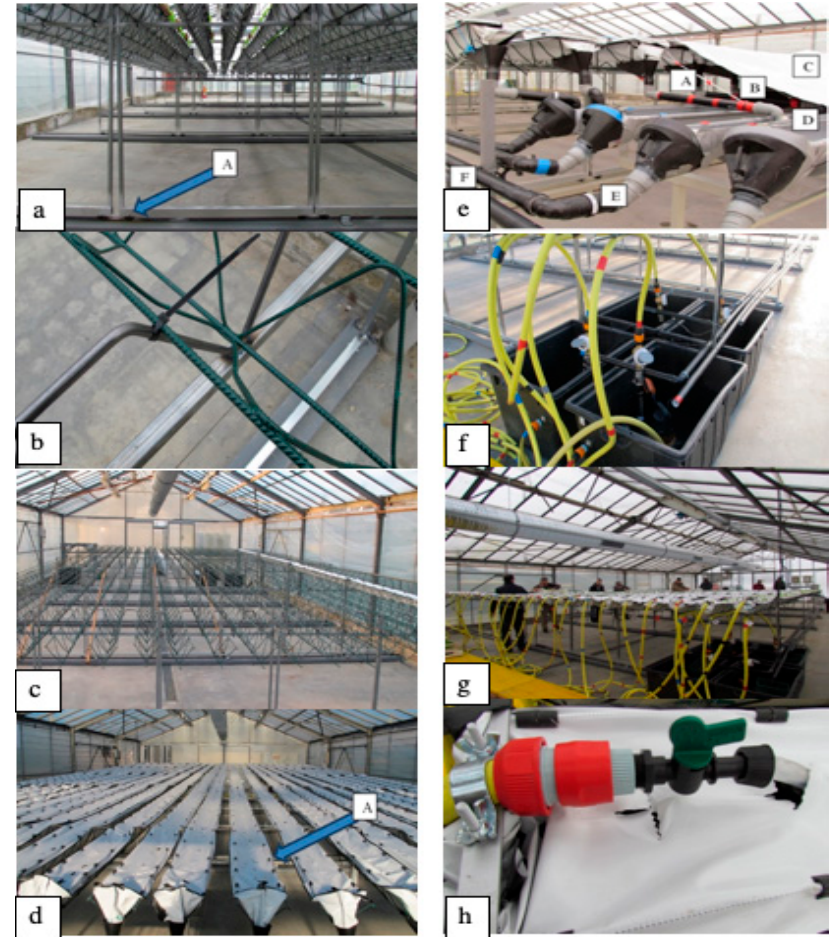
Figure 3. ( a ): View of the NGS ® mobile supporting elements; (A) steel rail which allows lateral movement of the transversal support. ( b ): Details of the frame fixed to the transversal support. ( c ): View of the 24 NGS ® lines under preparation. ( d ): View of the 24 NGS ® lines equipped with the multi-channel film; (A) plastic clips used to fix the multi-channel film to the frame. ( e ): Drainage collection system of the 24 NGS ® lines: (A) plastic drainage funnel, elbow and plastic drainage pipe that collect the HNS from the line; (B) elbow that directs the HNS drained to the gutter; (C) plastic film used to reduce the heating effect and prevent both evaporation and algae formation; (D) gutter that collects the HNS drained from six pre-assigned lines; (E) funnel, pipe and elbow that collect the HNS drained from the gutter; (F) plastic drainage connection pipe that returns the HNS drained to the drainage tank. ( f ): View of the four drainage tanks, each of which receives the HNS drained from six lines. ( g ): View of the hosepipes that convey the HNS to the NGS ® lines. ( h ): Details of the HNS distribution system attached to the multi-channel